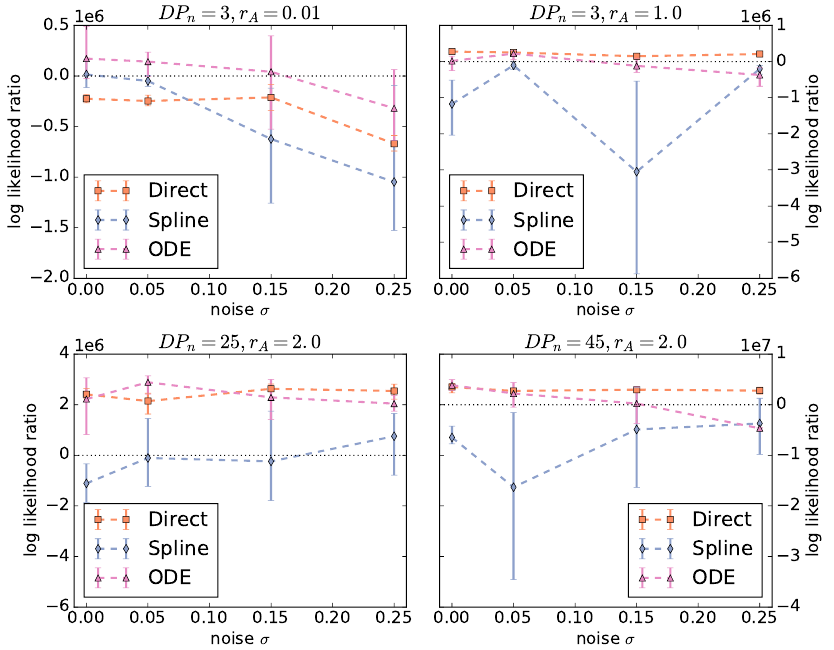
Figure 3. Log likelihood ratios of the results computed by the optimization algorithms as a function of noise. The ratios are averaged over all three algorithms for each fingerprint-generating function (direct, spline, ODE). The higher the ratios, the better the observed data is “explained” by the identified model parameterizations. If the ratio is below zero, the null model achieves a higher likelihood than the geometric model with the given parameterization.